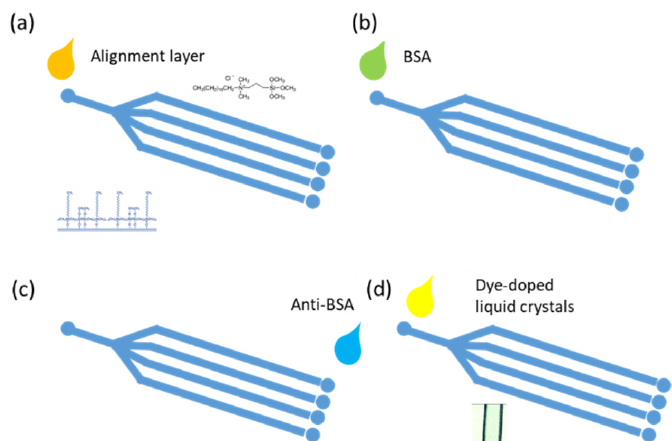
Figure 1. Schematic of microfluidic dye-doped liquid crystal (DDLC) biosensor chips in the presence of bovine serum albumin (BSA) biomolecules.